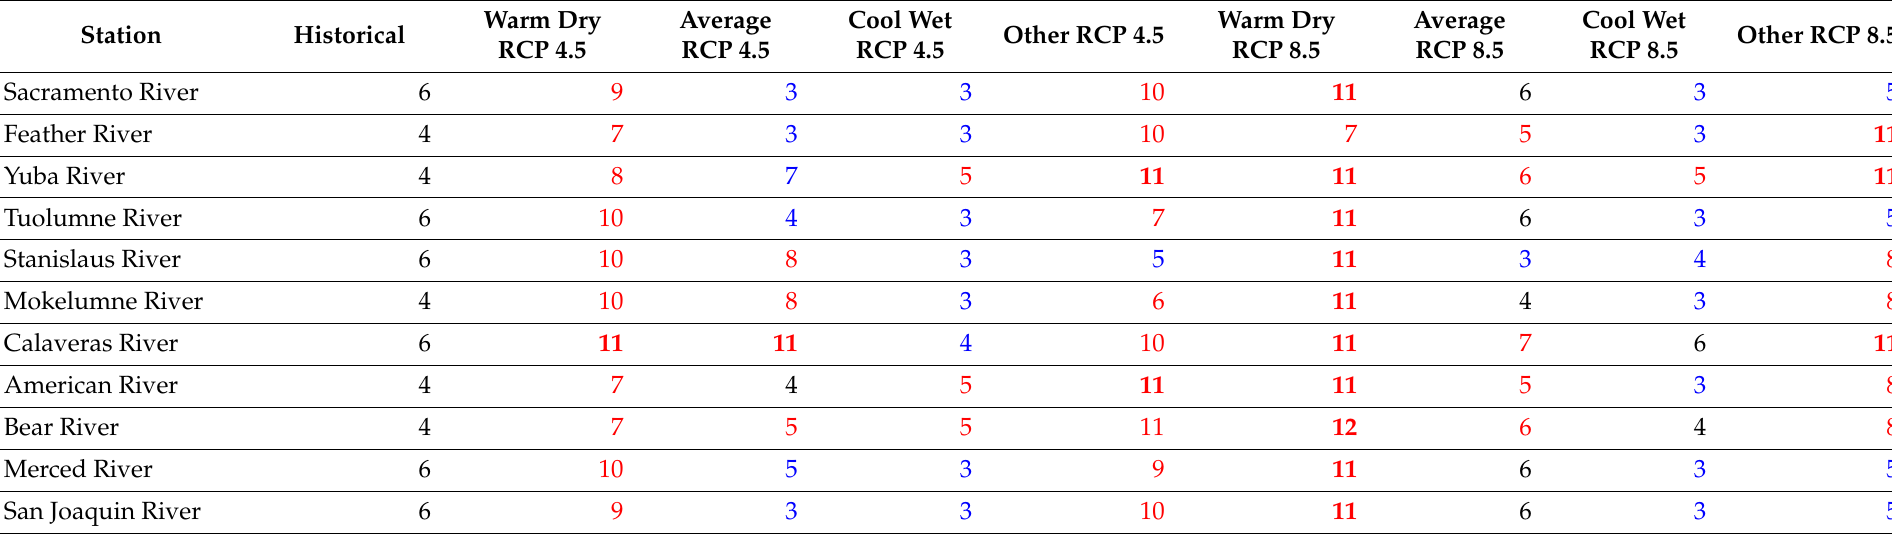
Table 4. Longest drought duration (years) by projection model for each streamflow station. Each of the values represent the longest drought out of all projected droughts under each climate scenario or historical records. Red highlighting indicates a longer drought than historical. Blue highlighting indicates a shorter drought than historical. Bold values are the longest projected drought for each station. (Note: 1 MAF = 1233 million cubic